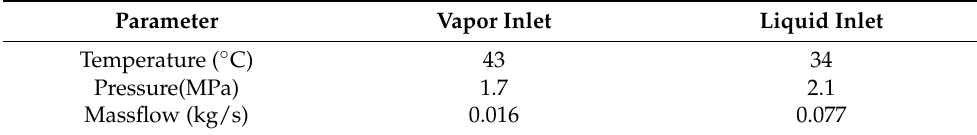
Table 21. Operating parameters from Bergander et al. [83].